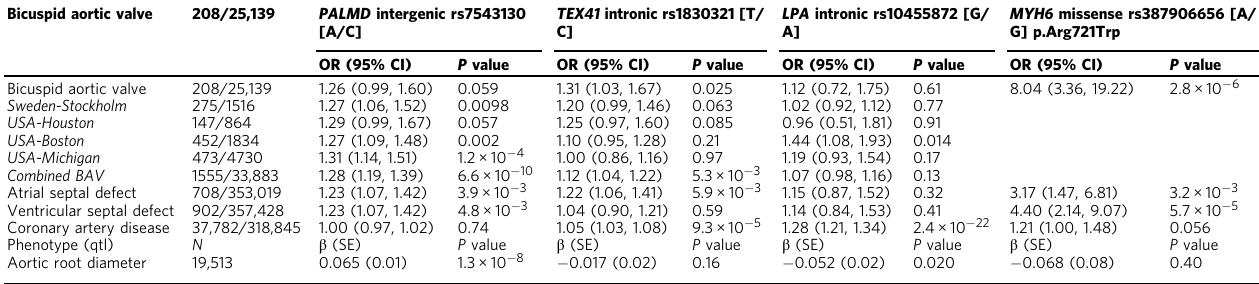
Table 2 Association of aortic valve stenosis variants with other cardiovascular traits Bicuspid aortic valve